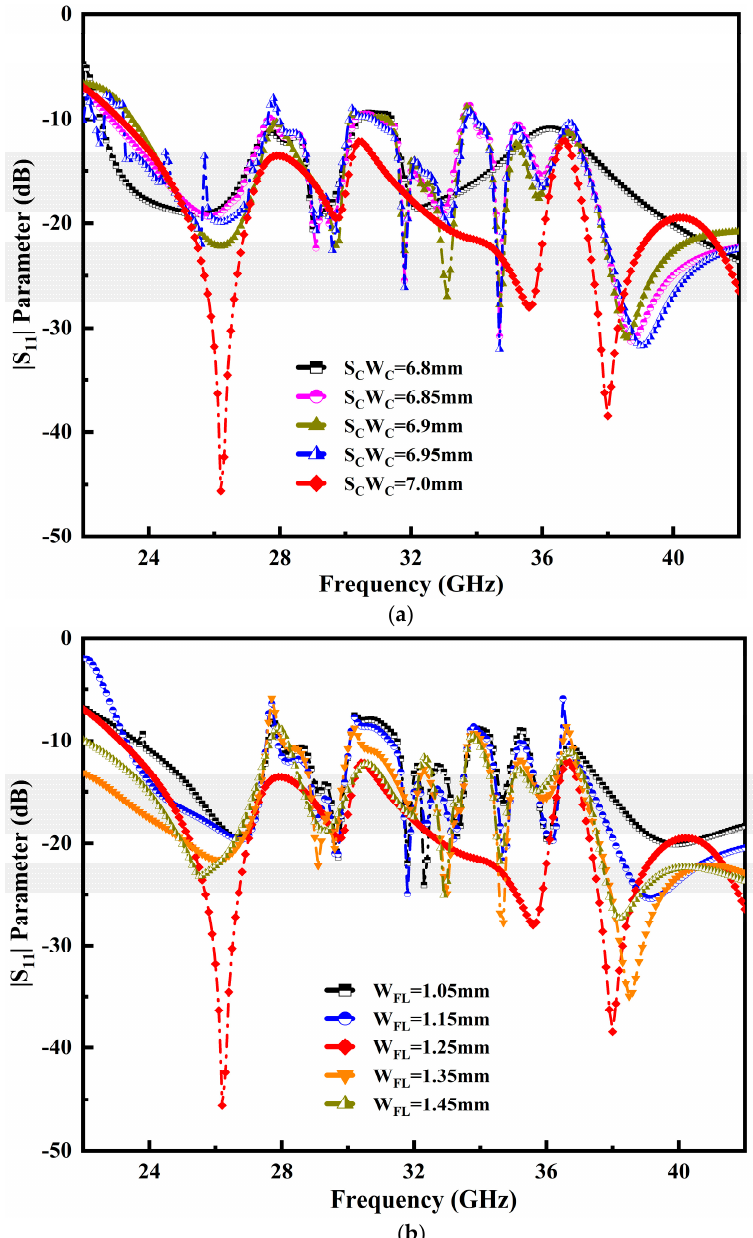
Figure 5. Influence of variation of variables: ( a ) return loss |S 11 | of the semicircular radiator (S C W C ), ( b ) feedline width (W FL ) over the operable frequency range.